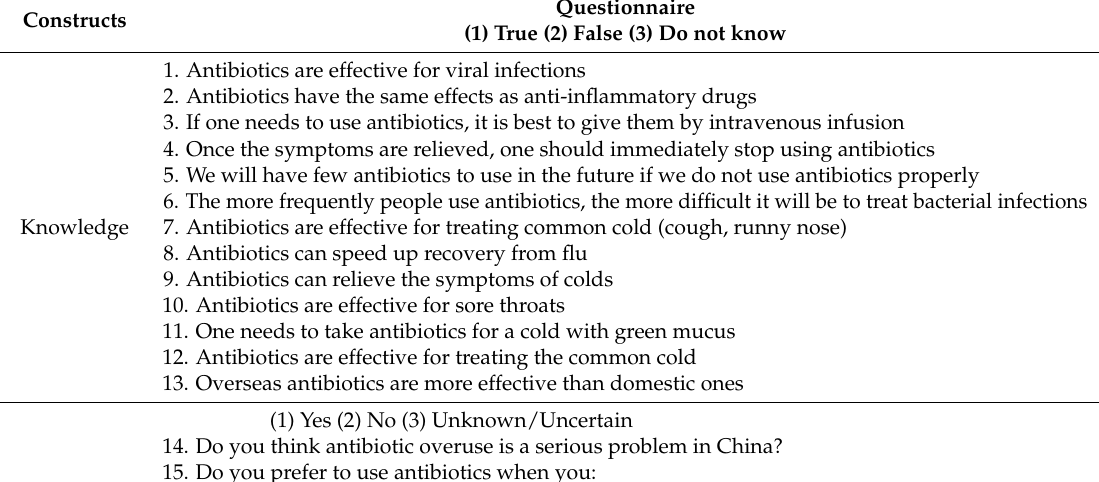
Table 1. Questionnaire details were based on knowledge, attitude, and practice (KAP) constructs in the survey among medical students in China in